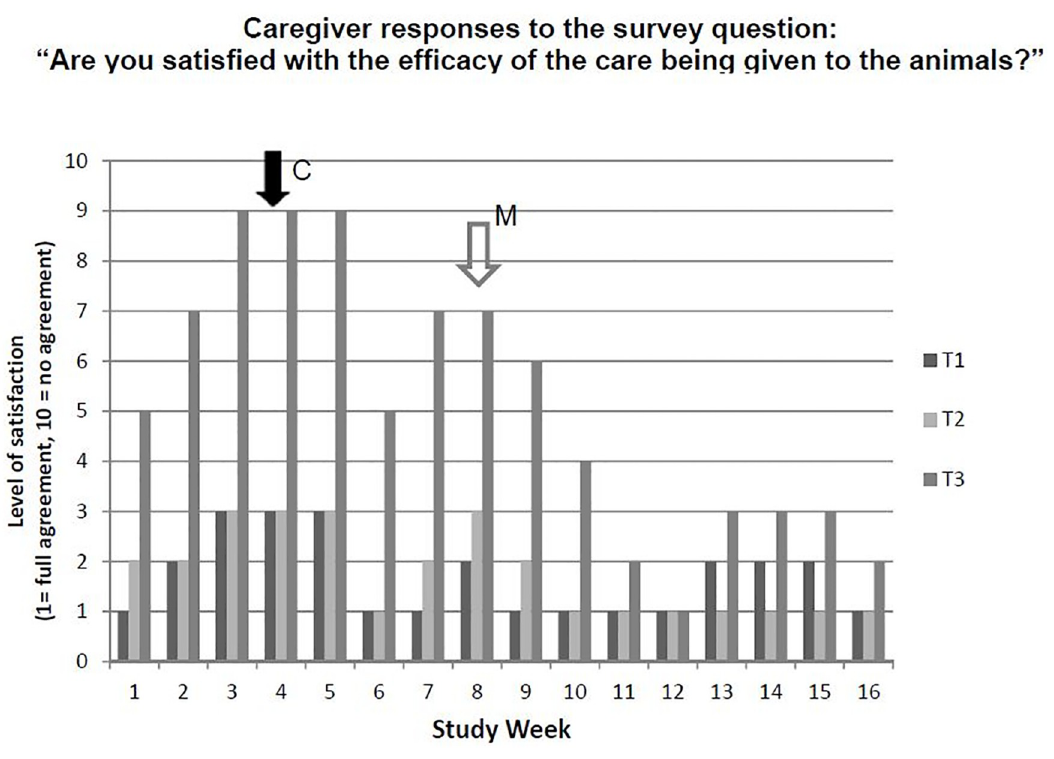
Fig 3. Caregiver responses to the survey question ‘Are you satisfied with the efficacy of the care being given to the study animals?’. Response are shown as mean values on a 10-point scale from 1 (full agreement) to 10 (no agreement). Responses were based on the observed health status of pigs in each treatment group at each week of the study. For the first 11 weeks of the study, satisfaction scores were most favorable for T1 and T2 pigs at each time point compared to scores for ABF (T3) pigs. Relatively favorable scores for the T1 and T2 groups reflected the absence of clinical disease due to infection control treatment on day 0 or subsequent therapeutic AB treatment, which was denied in T3 pigs. C = challenge with PRRSV; M = group medication of pigs in all three groups, including T3